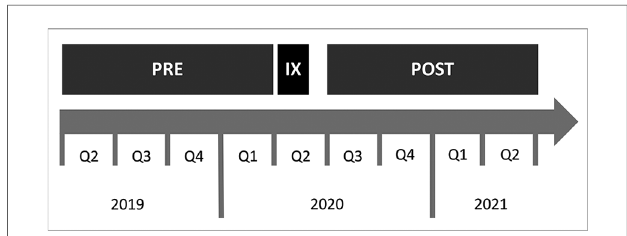
FIGURE 1 Study design. Notes: PRE: Pre-observation period (April 2019 – March 2020); IX: Index period (April – May 2020) *; POST: Post-observation period (July 2020 – June 2021). * Context: The Robert Koch Institute issued the recommendation for every acute respiratory symptom (irrespective of their severity) to be tested for COVID-19 as of March 24 2020. The sentence “ without known risk factors (COVID-19 diagnostic only if enough testing capacity available) ” was deleted as of April 22 2020 (25). In the index period the prevalent virus variant in Germany was the wild type